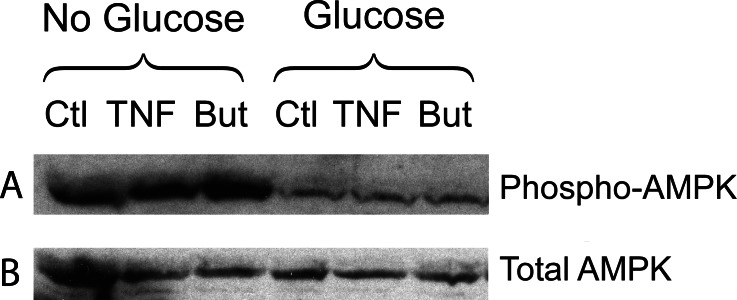
Effect of butyrate on phosphorylation of AMPK.3T3-L1 adipocytes were treated with or without 25 mM glucose and 50 ng/ml TNF-α or 5 mM butyrate for 6 h. Total protein extracts were prepared and Western blots were performed with antibodies raised against phospho-AMPK (T172) (A) or total AMPK (B). Both ran at approx. 62 kDa. Data depicted are representative of three or more independent experiments.